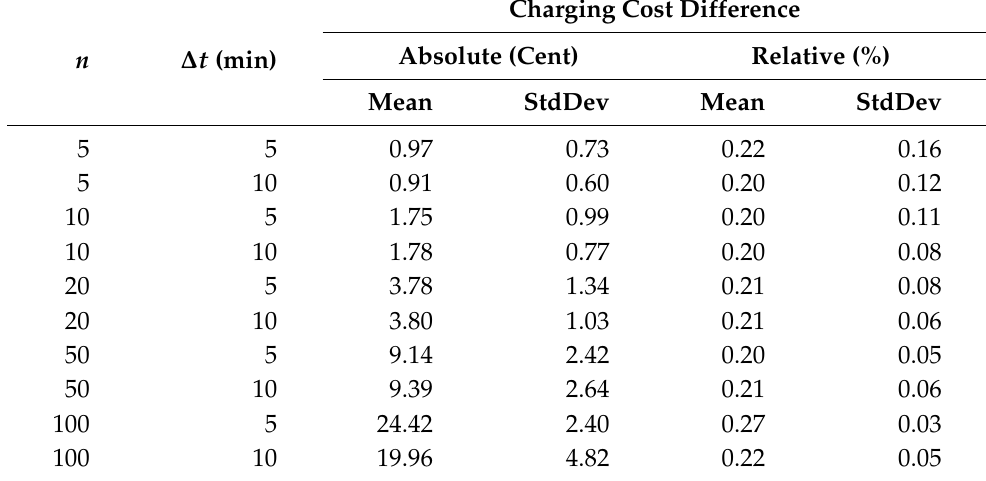
Table 9. Rolling horizon charging cost difference for EVS-SOC-LIN vs. EVS-SOC-GLIN using E max-lb v ; P gridmax = 40 n